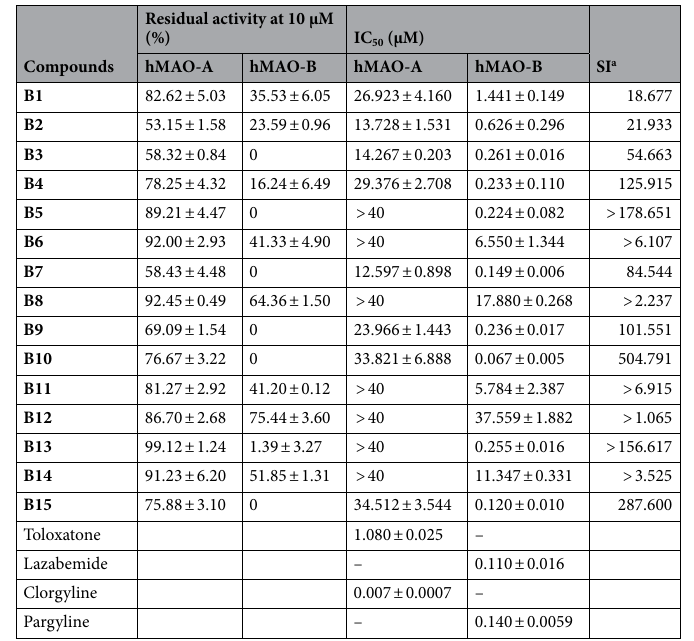
Table 1. Inhibitions of hMAO-A and hMAO-B by B series. Results are the means ± standard errors of duplicate or triplicate experiments. a Selectivity index (SI) values are expressed for hMAO-B as compared with